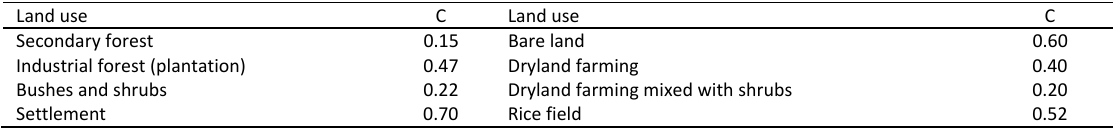
Table 2: Runoff coefficient (C) for land use types